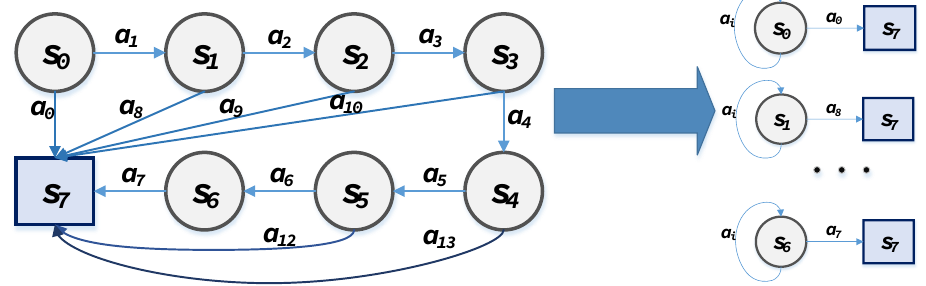
Figure 8. Suitable for frequency agile scenario state-action transition